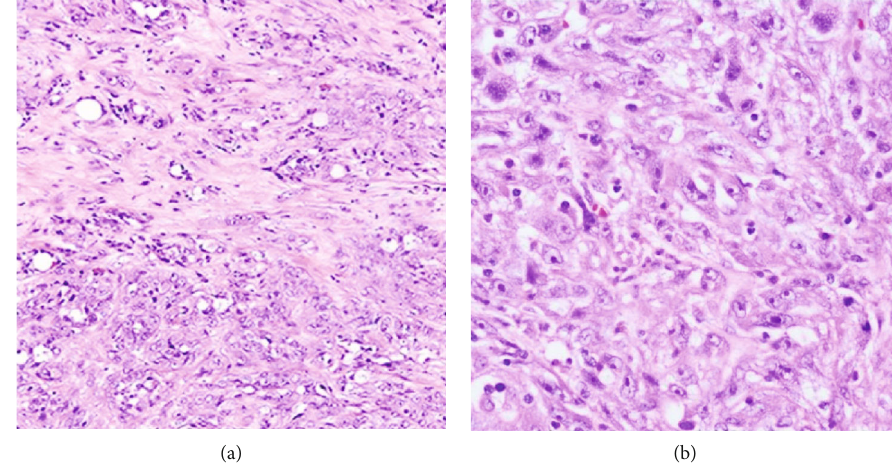
Figure 4: Microscopic appearance of the tumor showing (a) complex, in fi ltrative, and poorly circumscribed cells with some cords and tubules ( × 10) and (b) carcinomatous proliferation formed by polygonal cells with eosinophilic and dense cytoplasm and an irregular hyperchromatic nucleus with multiple nucleoli and occasional presence of clear cells ( ×